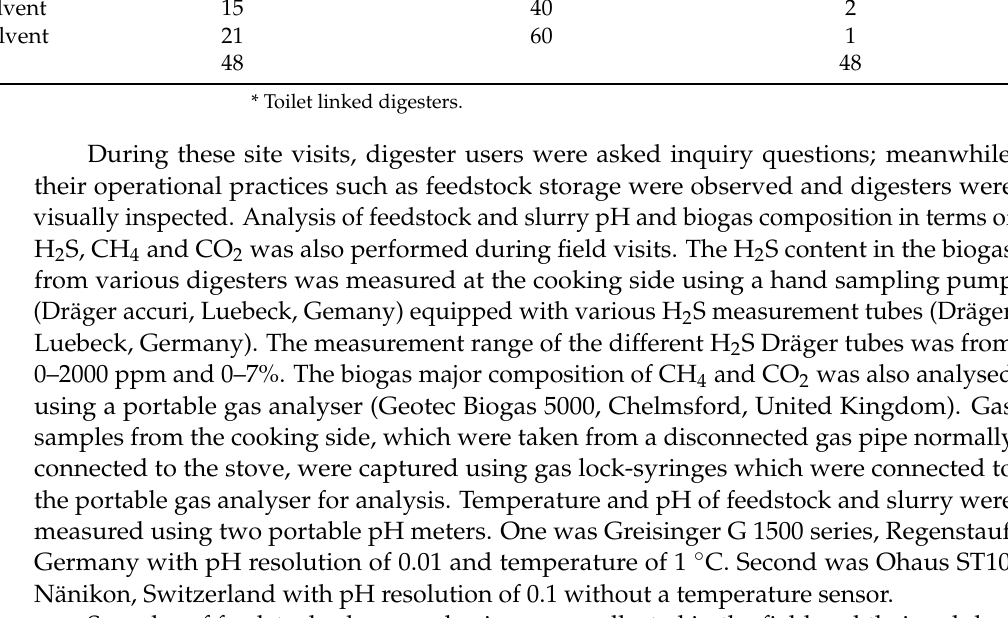
Table 1. Type of feedstock used and the size of the digesters visited during the fieldwork in Uganda. Number of Digesters Numberof Digesters Type of Feedstock Depending on the Type Size of the Digesters (m 3 ) Depending on the Size of Feedstock 6 6 11 9